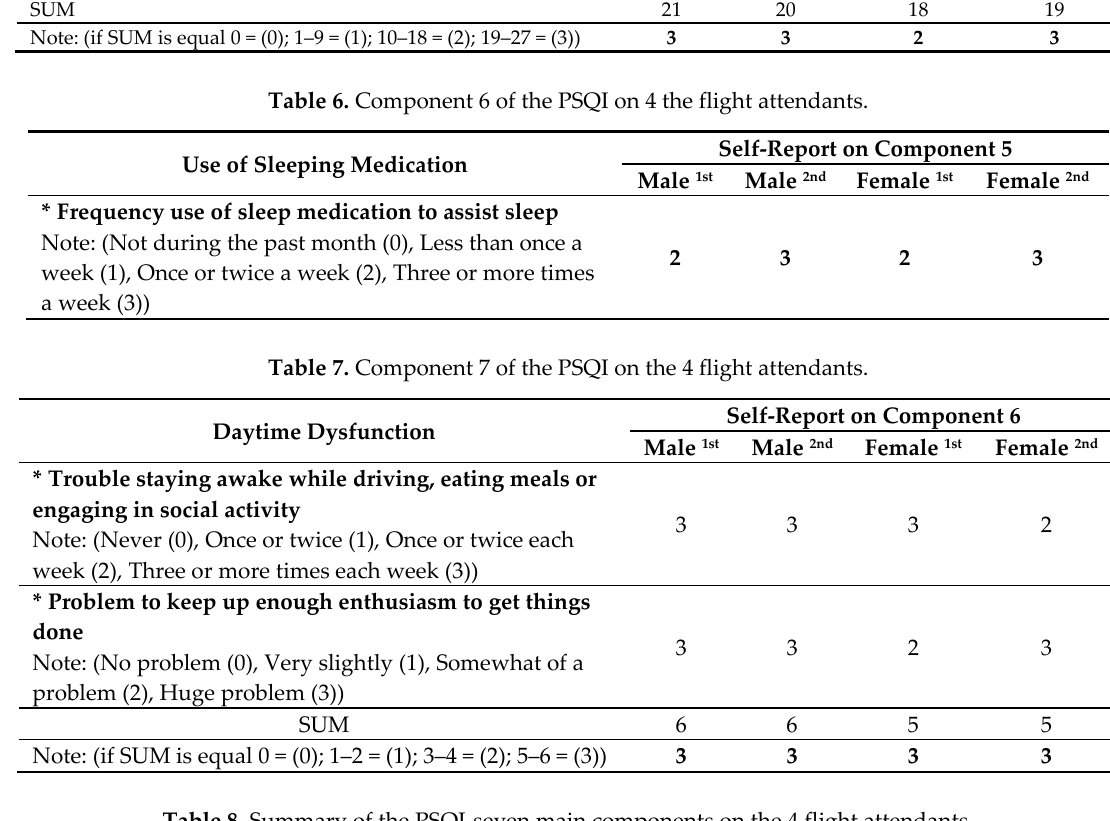
Table 8. Summary of the PSQI-seven main components on the 4 flight